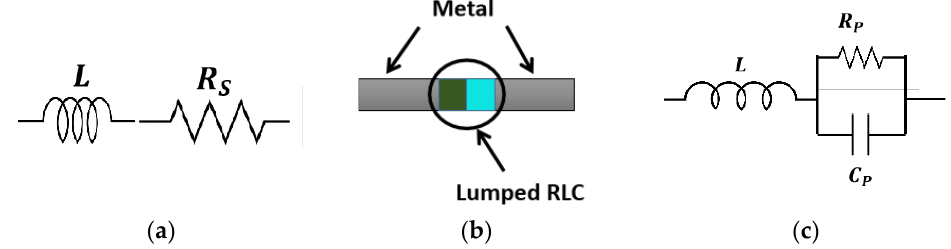
Figure 2. Equivalent circuit and layout of PIN diode: ( a ) ON condition; ( b ) Design format; ( c ) OFF